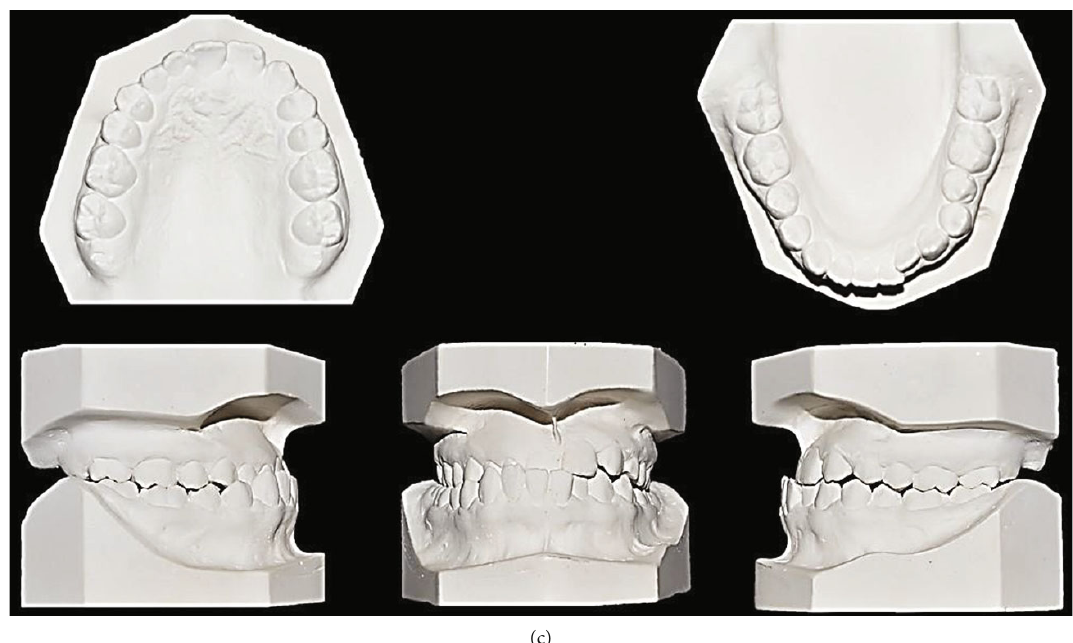
Figure 2: Pretreatment cephalometric radiograph, panoramic radiographs, and study models: (a) cephalometric radiograph, (b) panoramic radiographs, and (c) study models.